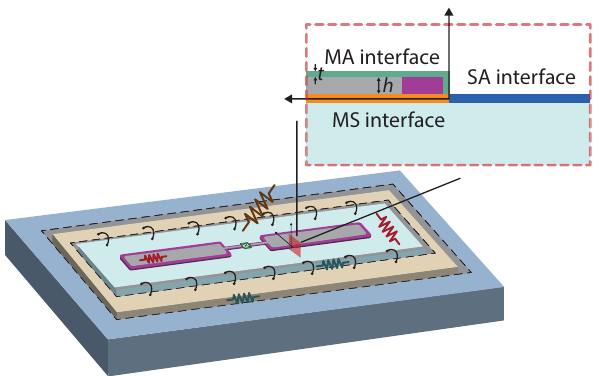
FIG. 7. Potential losses in a planar cQED device. An illus- tration of various noise channels that are present in a device. Here, a lithographically patterned chip is positioned within a circuit board holder (light yellow), which in turn sits within a metal enclosure (blue). This environment can be lossy (modeled by resistors) due to effects such as unwanted couplings (teal), spurious modes (red), material dissipation (maroon), and radia- tion (dark brown), etc. Inset: A cross section of an edge of the lithographic structure to highlight the surface losses due to dif- ferent interfaces. The three interfaces of interest with thickness t are shown as MS (orange), MA (green), and SA (blue). The divided regions of the superconductor (thickness h ) refer to the interior regions (gray) and perimeter regions (purple). Their indi- vidual contributions are simulated and compared across different designs in Ref.